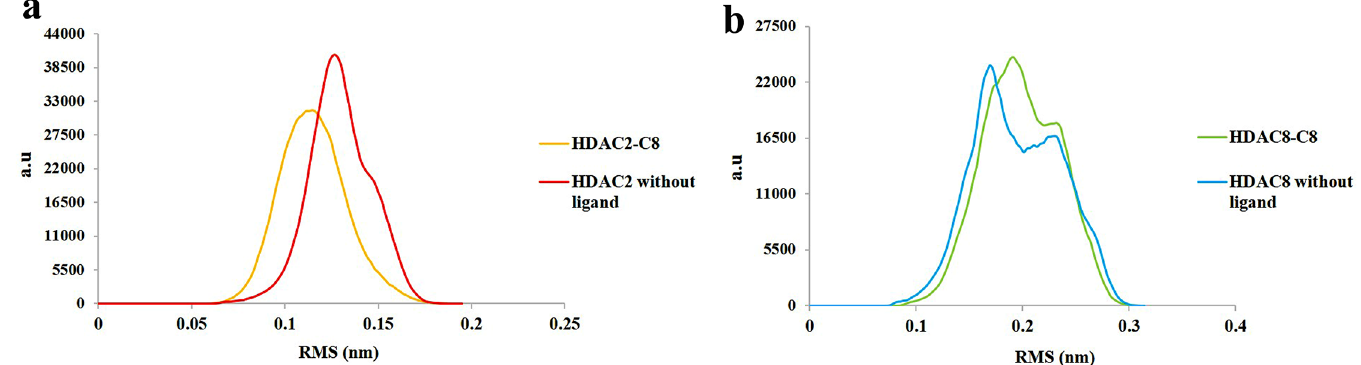
Fig 11. RMS distribution for 12 ns MD simulation. (a) RMS distribution pattern for HDAC2-C8 complex (yellow) and HDAC2 without ligand (red). (b) RMS distribution for HDAC8-C8 complex (green) and HDAC8 without ligand (blue).